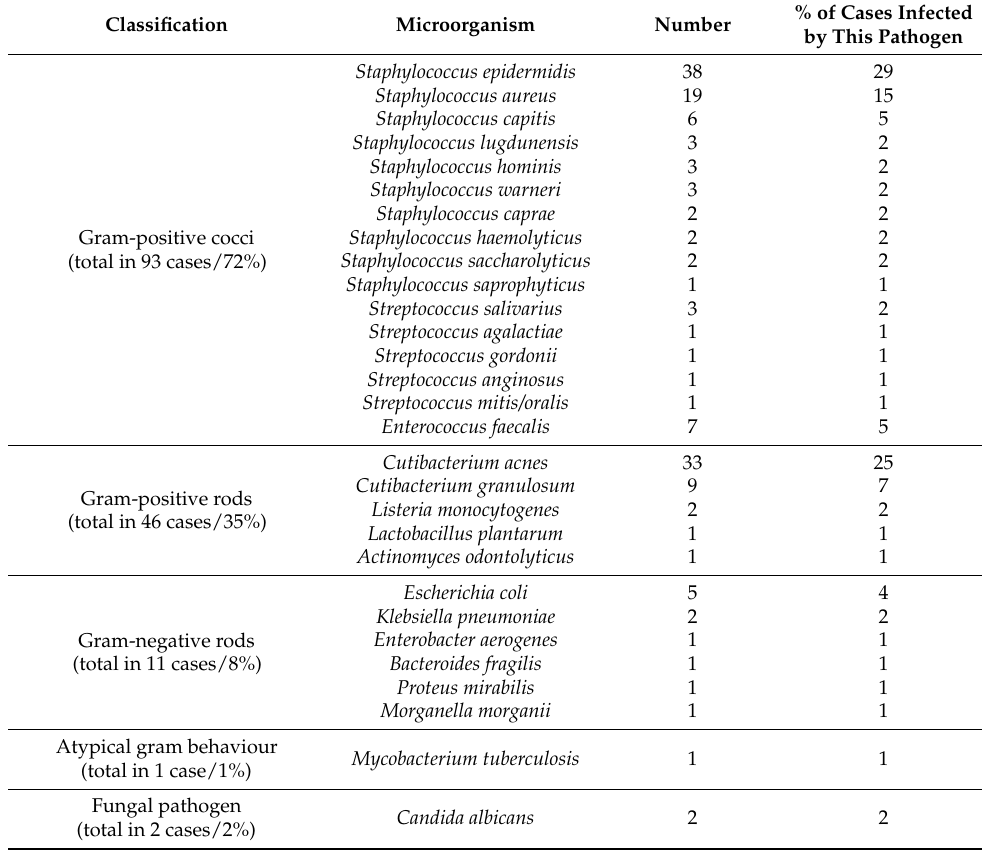
Table 3. Identified microorganisms and the number of detections.